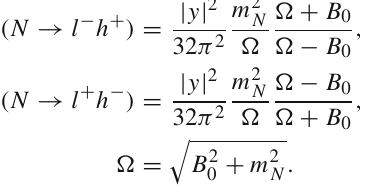
Majorana neutrino N with the corresponding Yukawa cou- pling for the Higgs portal y . For N , the tree-level decays (cf. Fig. 1) for the two channels (9), in the presence of the background B 0 , yields in that